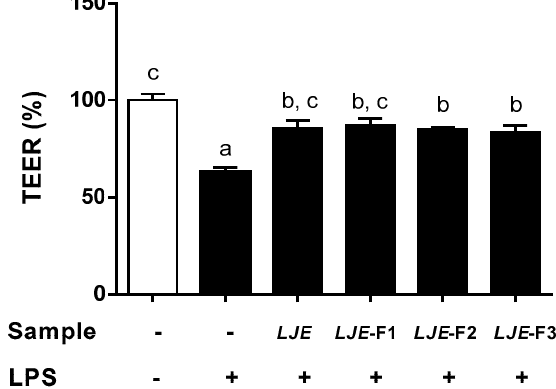
Figure 4. Effects of LJ and LJE-Fs on permeabilization of Caco-2 cell monolayers measured by transepithelial electrical resistance (TEER (%). Caco-2 cell monolayers were preincubated with 100 µ g / mL LJE, LJE-F1, LJE-F2, or LJE-F3 for 6 h, and the cells were incubated for an additional 24 h with 1 µ g / mL LPS. Caco-2 cell monolayer permeability was evaluated by measuring TEER. The results are shown as mean ± SEM of three independent experiments. Values that do not share the same superscript are significantly di ff erent by one-way ANOVA with Tukey’s comparisons test ( p <